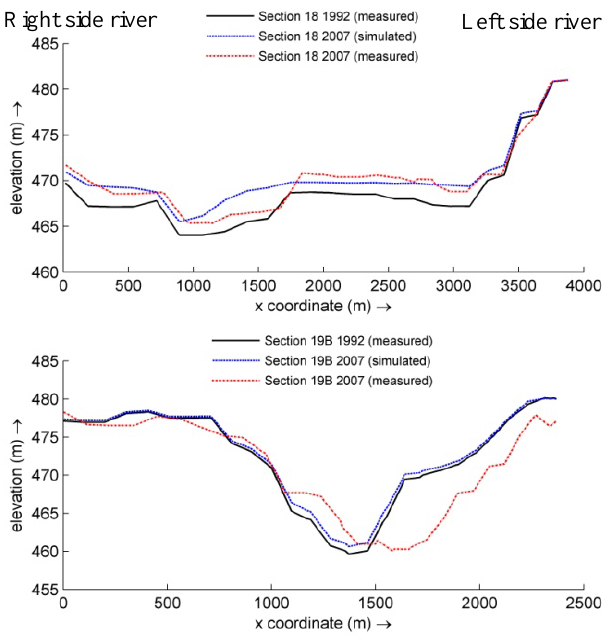
Figure 10. Cross sections 18 and 19B seen from downstream. Mea- sured 1992 and 2007 bed elevations and simulated 2007 bed eleva- tion. Cross sections 18 and 19B are located 10.8 and 15.4km up- Fig. 10. Cross-sections 18 and 19B seen from downstream. Measured 1992 and 2007 stream of the dam, respectively. bed elevations and simulated 2007 bed elevation. Cross-section 18 and 19B are located 10.8 km and 15.4 km upstream of the dam, respectively.